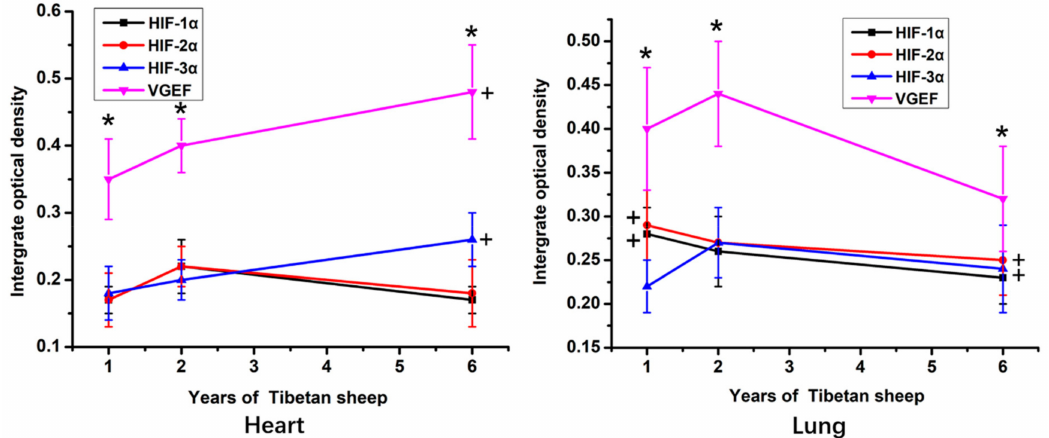
Figure 3. The IOD (Integrated optical density) value of hearts and lungs of Tibetan sheep of di ff erent ages. VGEF is vascular endothelial growth factor, HIF is hypoxia-inducible factor. Values are means ± SD ( n = 10). * indicates that significant di ff erences ( p < 0.05) in the IOD values existed between immunostaining intensity for VEGF and all three HIFs at that time point. + indicates significant di ff erences in the immunostaining intensity of VEGF and HIF-1 α in the heart and HIF-1 α HIF-2 α in the lung between 6-year-old and 1-year-old